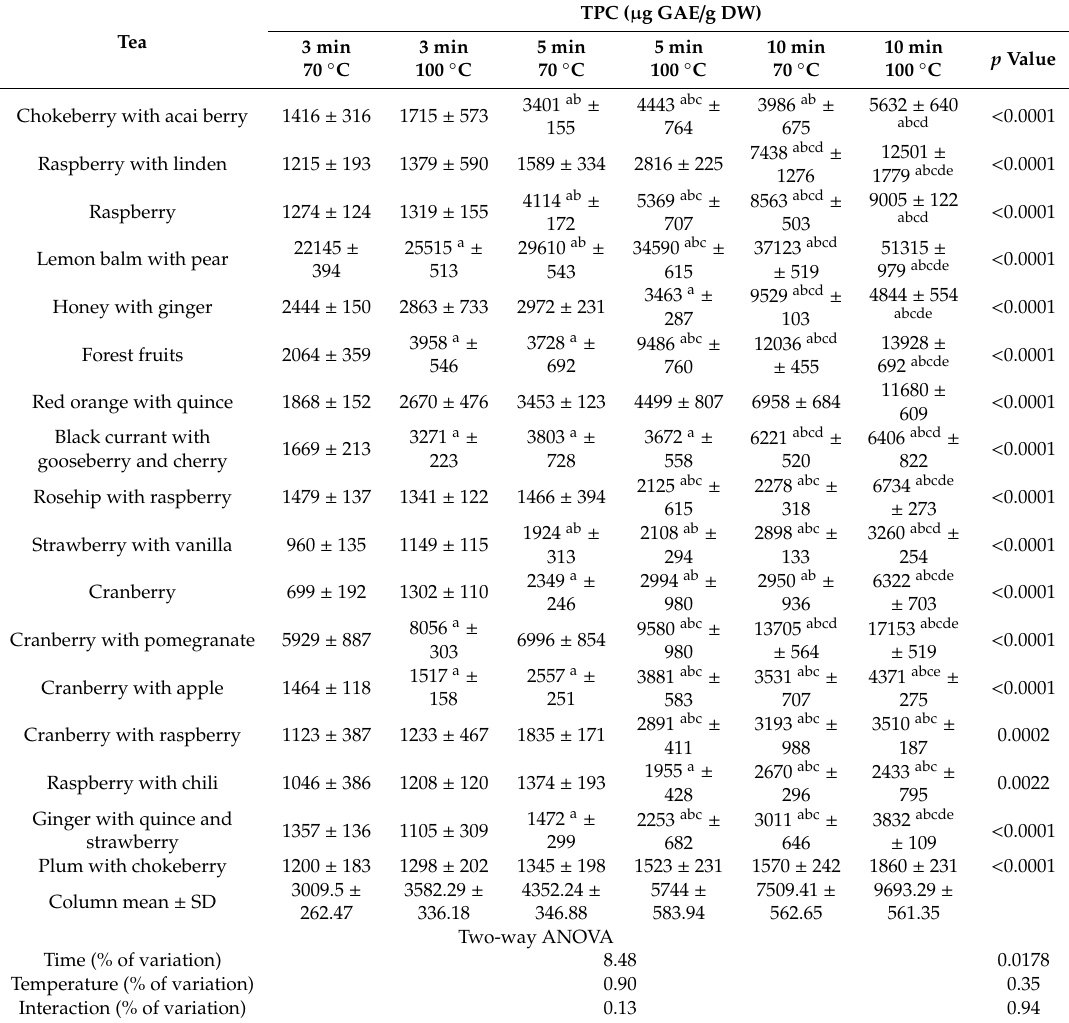
Table 5. Total phenolic content (TPC) in fruit tea infusions. a p < 0.05 vs. 3 min 70 ◦ C; b p < 0.05